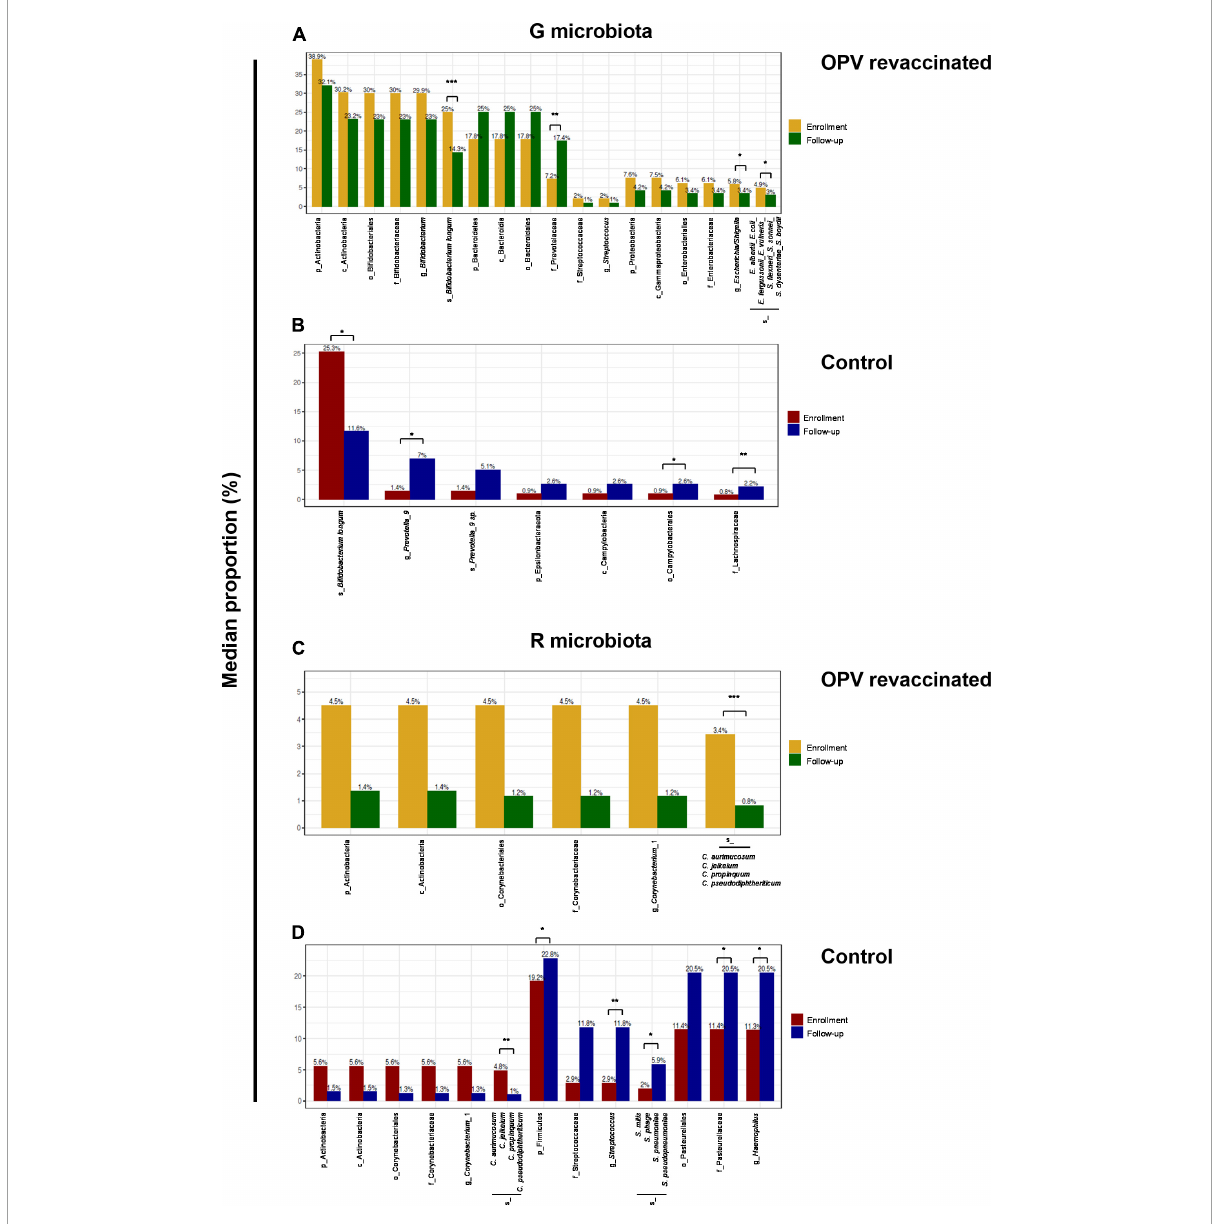
FIGURE5 Linear discriminant analysis effect size (LefSe) identified taxa with relative abundance greater than 1% that significantly changed over time. Differences in median proportion between taxa with a relative abundance greater than 1% that significantly changed from enrollment to follow-up in G and R microbiotas in oral polio vaccine (OPV) revaccinated infants (A,C) , respectively and Control (B,D) , respectively are shown. Median proportion of each taxon at both time points are displayed on the top of the columns. All differences over time shown in the graphics are significant. Adjusted p -values are displayed for those taxa mentioned in the text. * p < 0.05; ** p < 0.01; *** p <